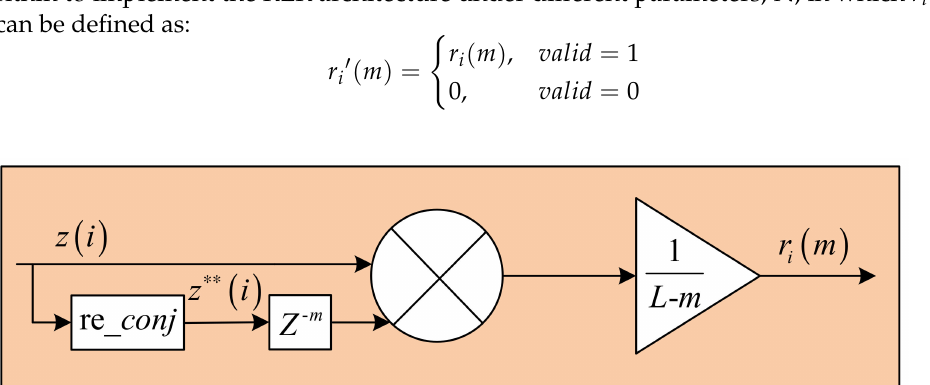
Figure 5. Sub-autocorrelation function